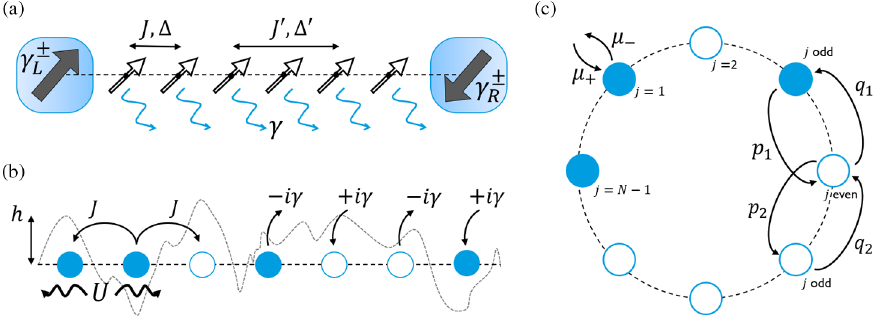
FIG. 5. Sketch of the three models studied: (a) A boundary-driven dissipative spin chain, Sec. IVA; (b) a non-Hermitian disordered many-body system, Sec. IV B; (c) a classical simple exclusion process, Sec. IV